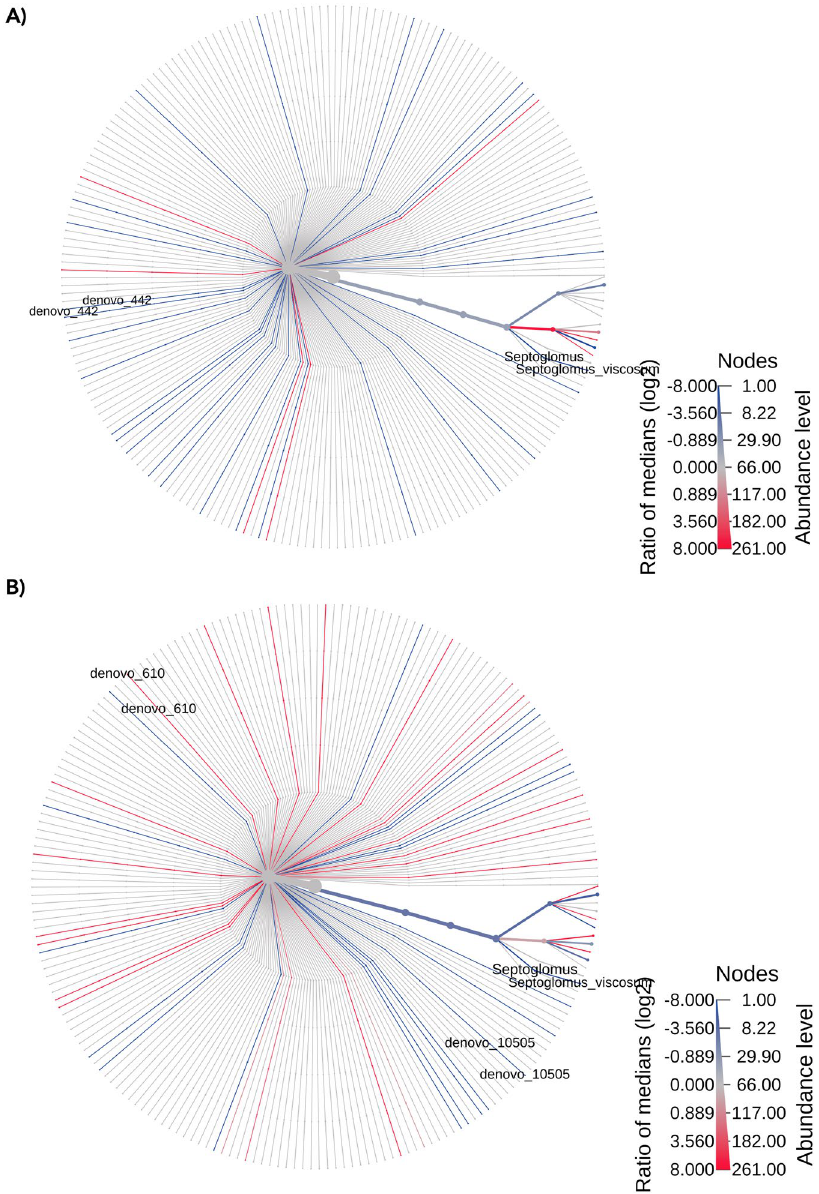
Figure 5. Heat tree of factor Space. Heat Trees report the effect of the presence of V. vinifera roots on hierarchical structure of taxonomic classifications (median abundance, non-parameter Wilcoxon